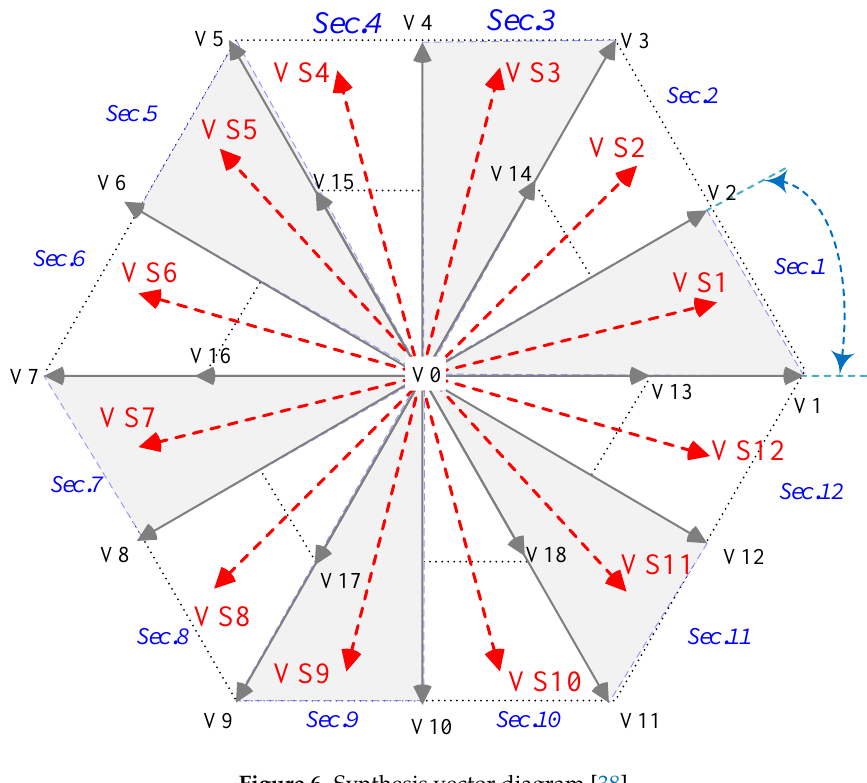
Figure 6. Synthesis vector diagram [38]. Table 2. Switching sequences used to generate synthesized voltage vectors